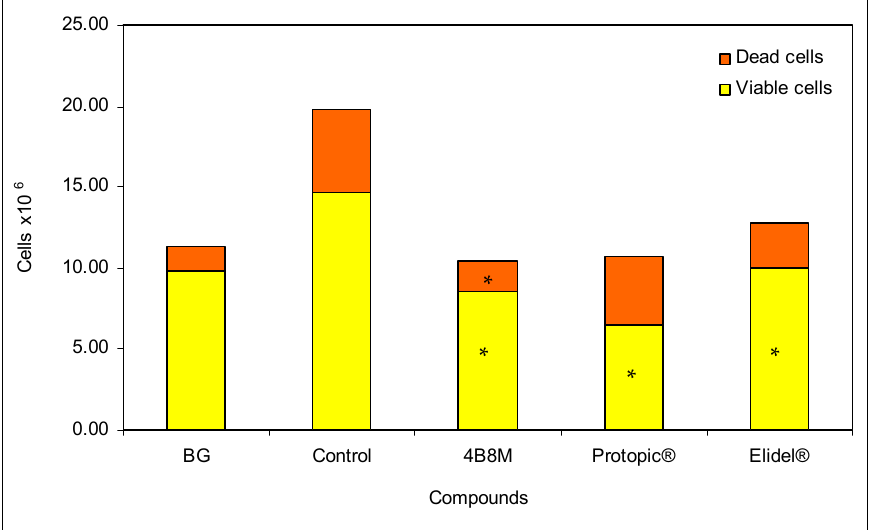
Figure 6. Total numbers of viable and dead cells in the draining lymph nodes: the experiment was performed as described in Figure 5. The number of cells was determined 24 h after the last elicitation of the reaction (28th day of the test). The results are presented as 10 6 cells for each group (mean values ± SE). * Control vs. compounds p < 0.05 (viable cells ANOVA; dead cells test of K-W).